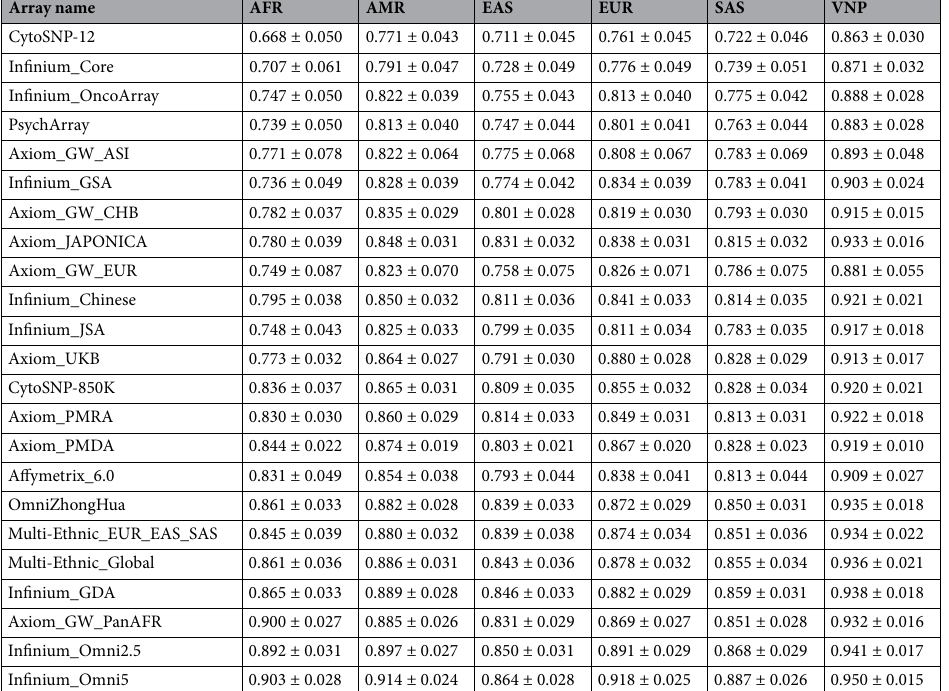
Table 2. Mean and the standard deviation of imputation accuracy r 2 measured in 22 autosomes at the MAF bin of (0.01–0.5].